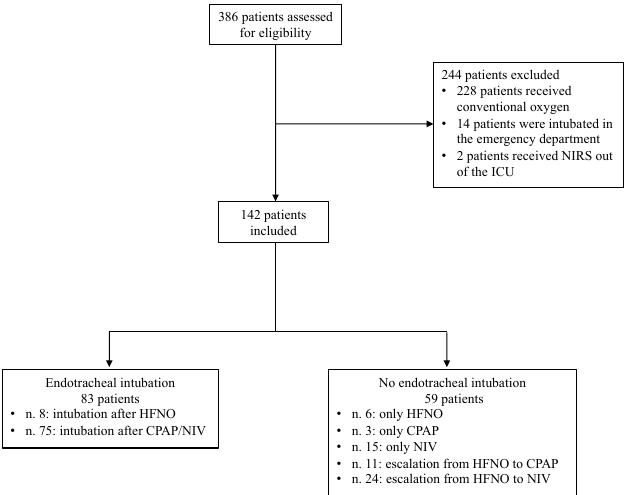
Figure 1. Patient selection flowchart. Abbreviations: NIRS, noninvasive respiratory support; ICU, intensive care unit; HFNO, high-flow nasal oxygen; CPAP, continuous positive airway pressure; NIV, noninvasive ventilation. Table 1. Patients’ baseline characteristics.